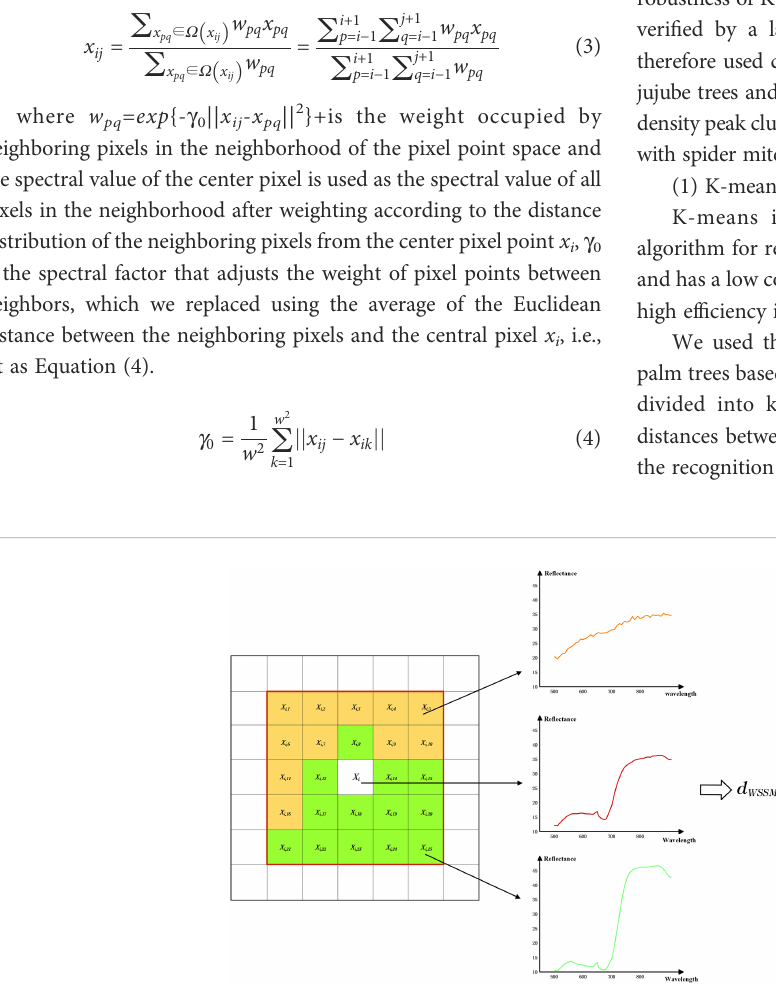
FIGURE 4 Weighted Spatial-Spectral Mean Filtering